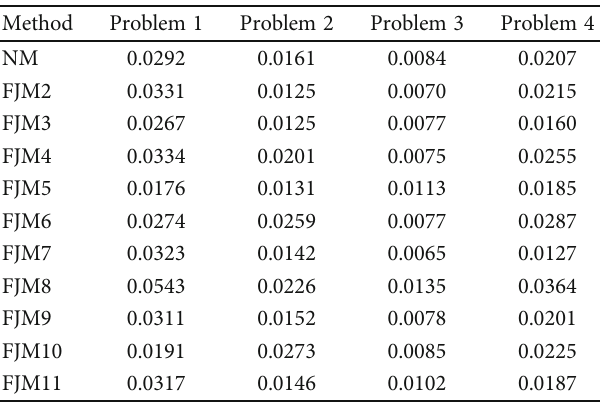
Table 12: Values of FJC2 for case n = 500